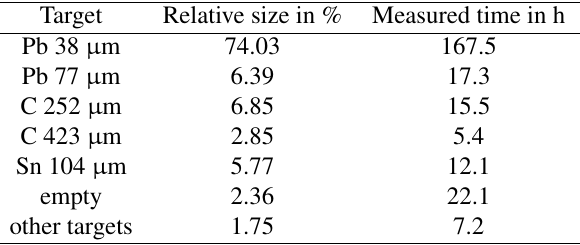
Table 1. Targets, relative file size compared to recorded data of 67 TB and measured time. In total, we measured for 247